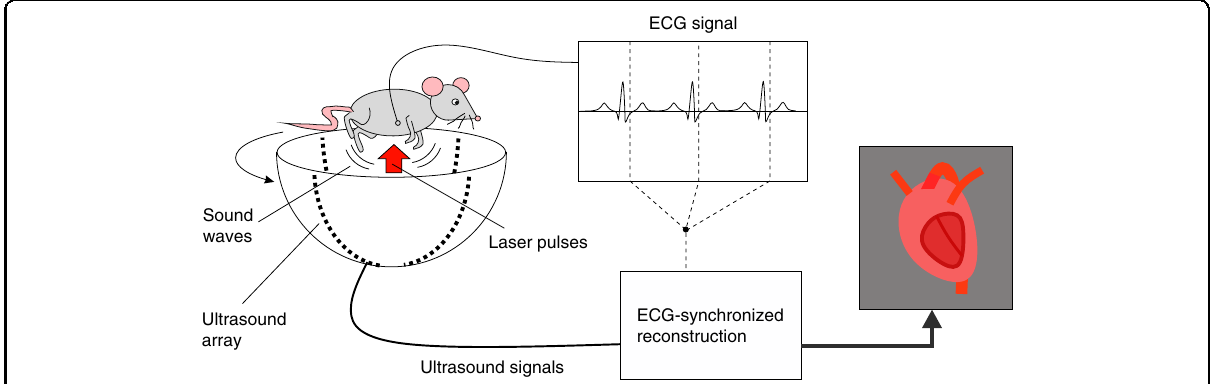
Fig. 1 Schematic of photoacoustic tomography, synchronized with the electrocardiogram for three-dimensional visualization of the beating heart of a